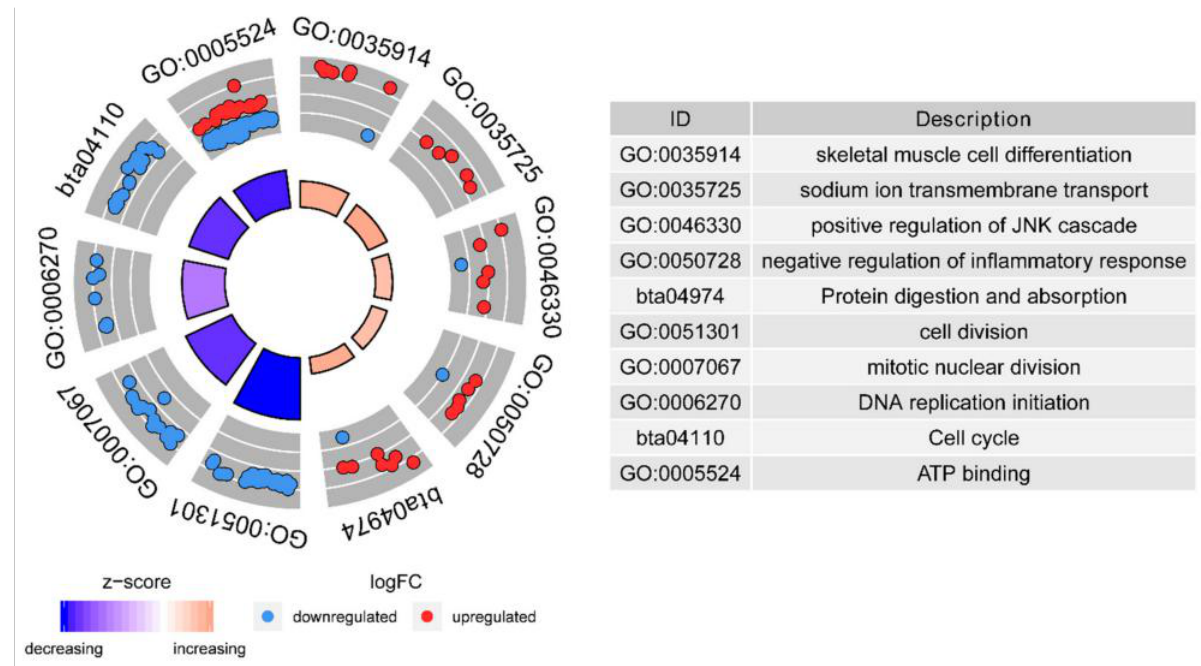
Figure 3. The GO circle of functional enrichment analyses with DEGs. Each segment of the circle shows the scatter plot the log2FC of the enriched genes. The red points display upregulation, and the teal-blue ones display downregulation. The bigger segment size of the inner circle indicated the higher expression of the enriched pathway. The darker the shade of blue means more decreasing. The darker the shade of red means more